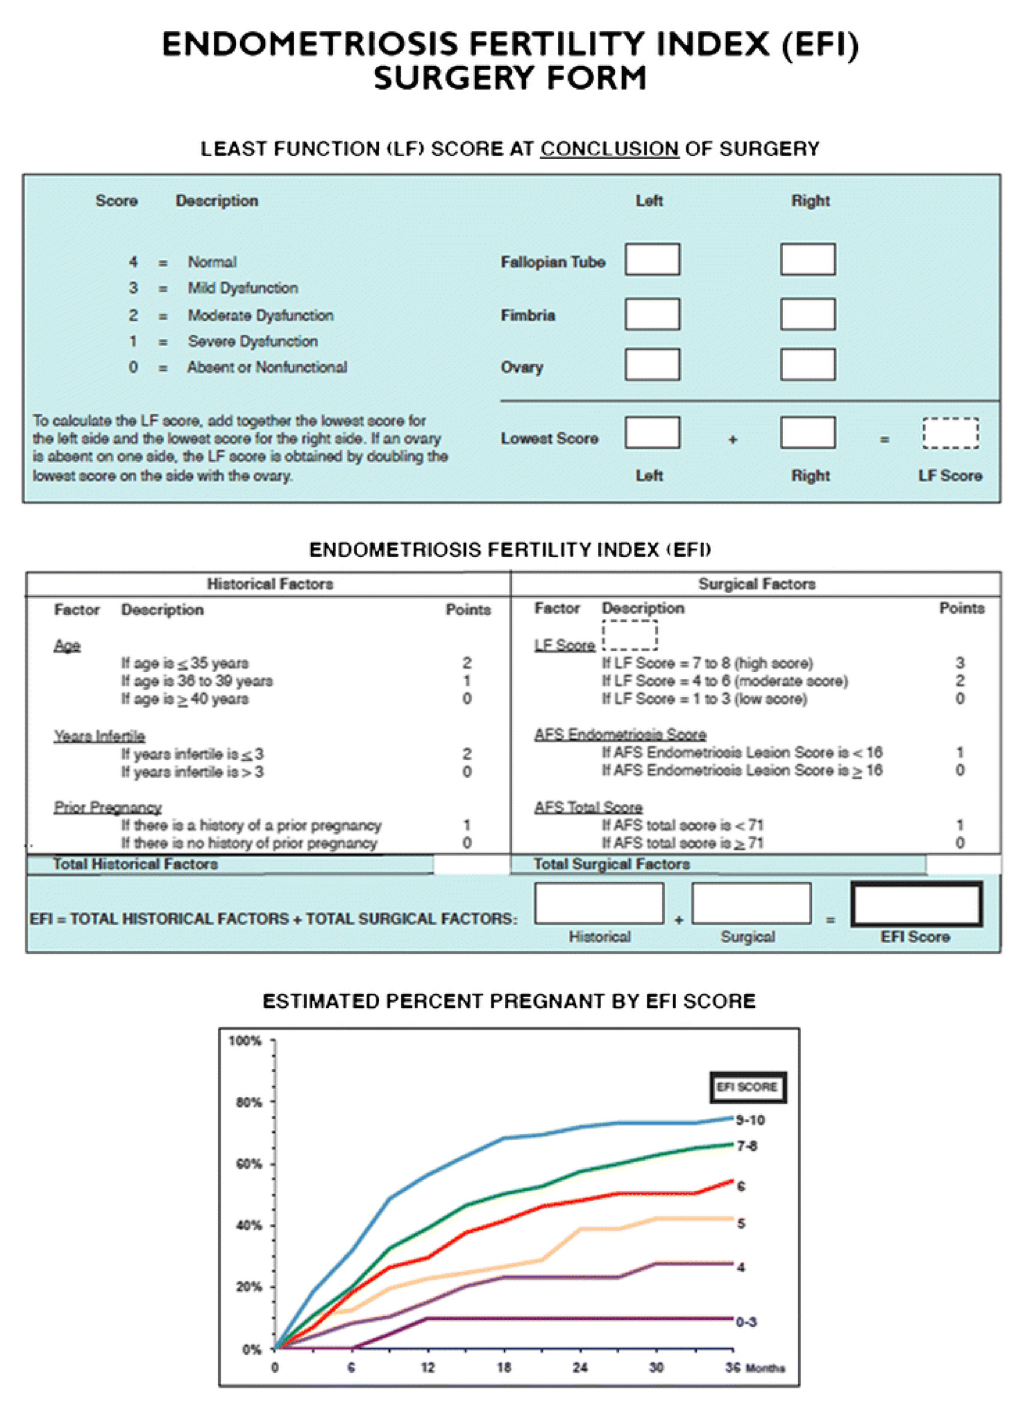
Figure 4. Endometriosis fertility